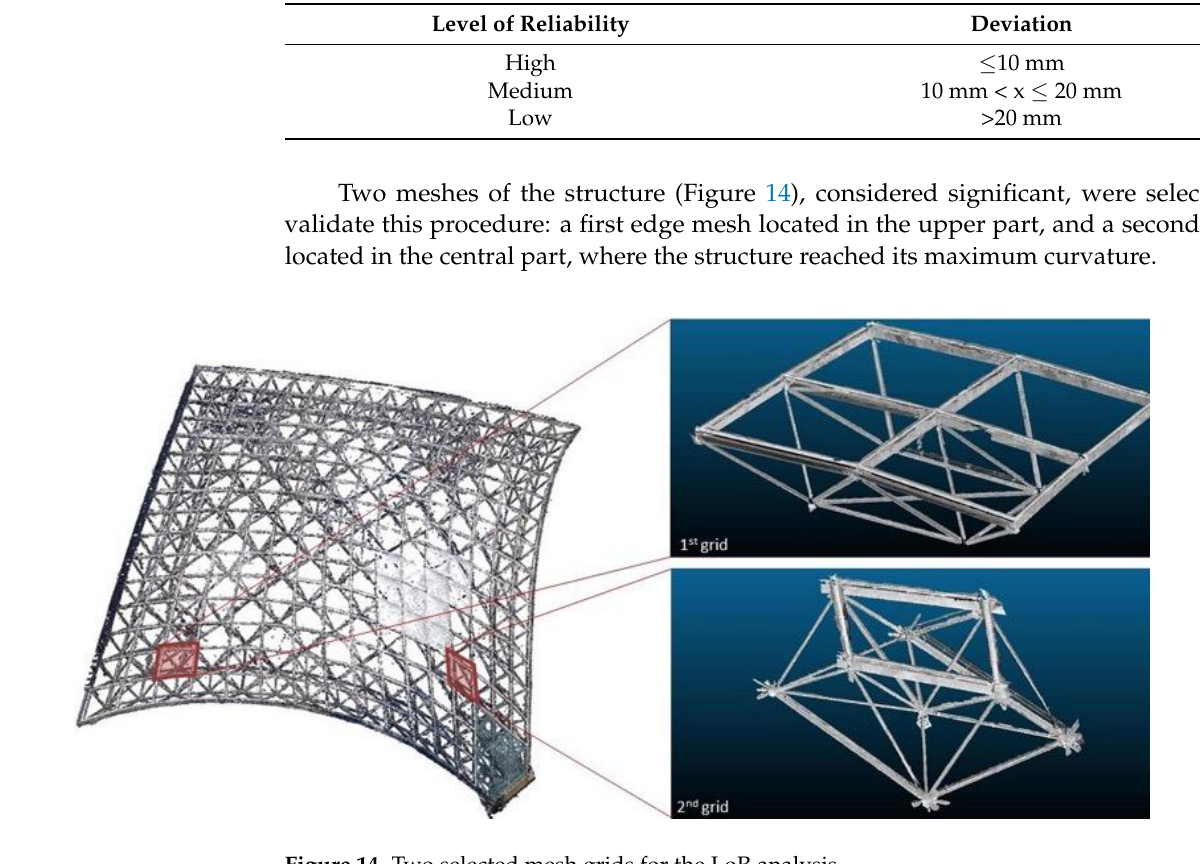
Table 1. Classes of reliability identified to evaluate the 3D reconstruction process.